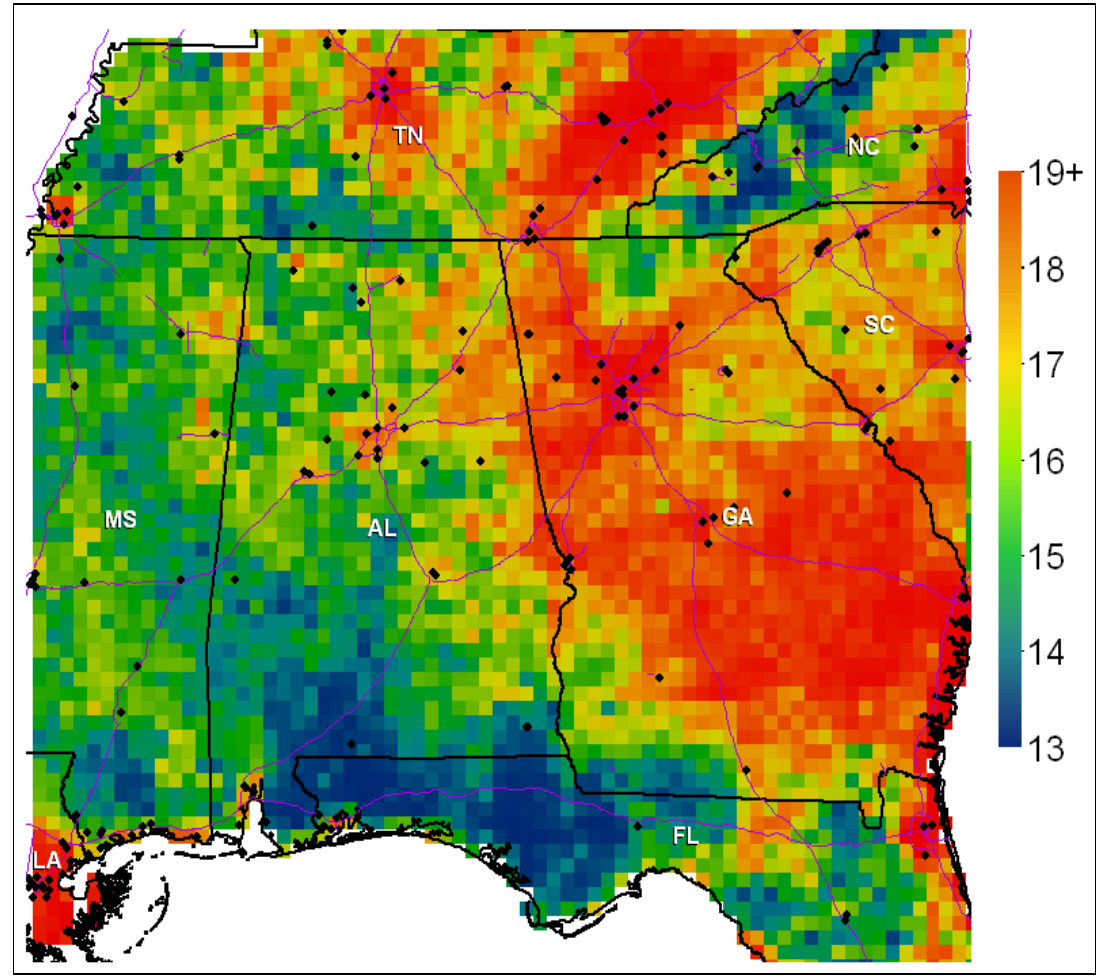
Figure 6. Estimated PM points showing air quality monitoring sites and lines depicting major highways in the